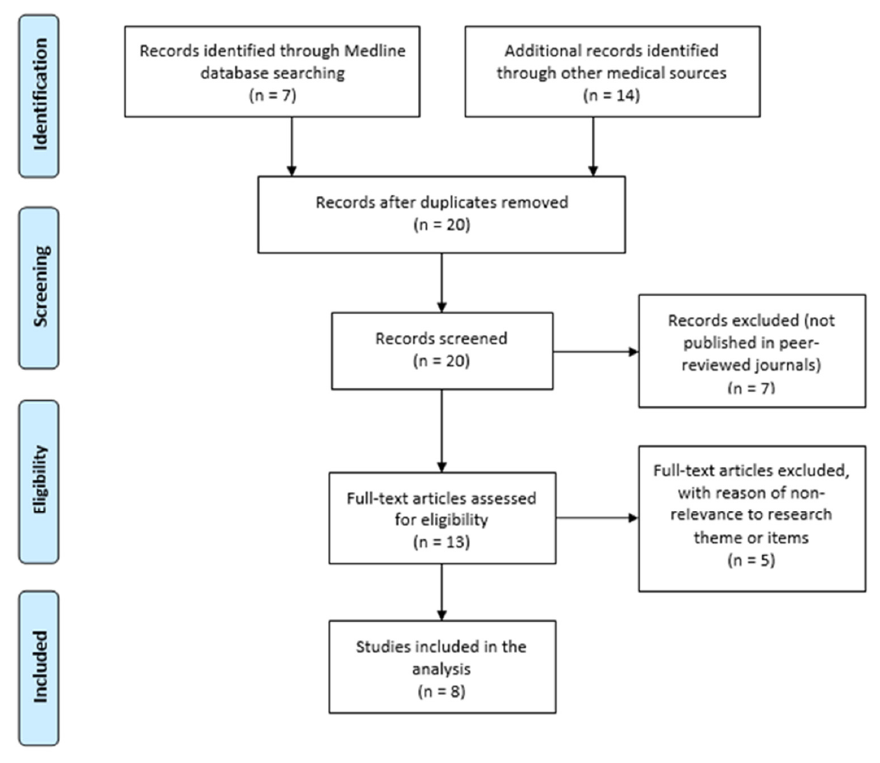
Figure 3. Flow diagram of the selection process for the literature review on the possible interaction between ME/CFS and COVID-19.